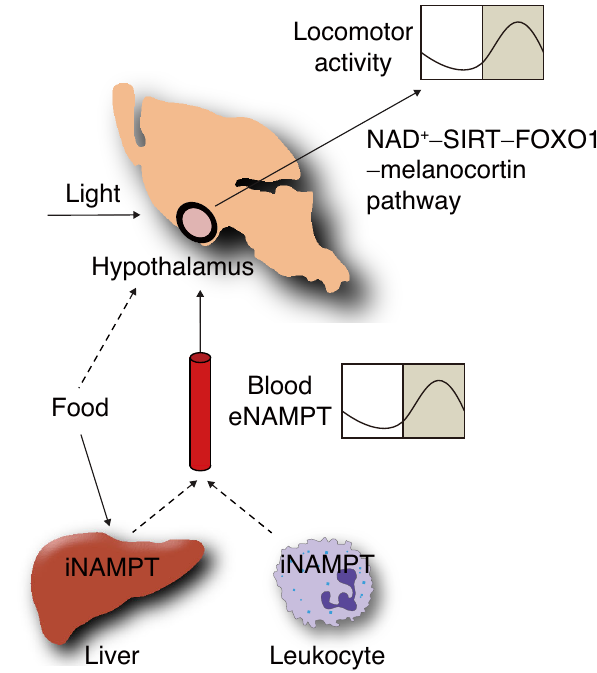
Fig. 8 | Schematic illustration of a potential role for eNAMPT in hypothalamic circadian regulation of locomotor activity. Light and food availability control eNAMPTsecretionfromtheliverorleukocytestosystemiccirculationinacircadian manner.Blood eNAMPTacts uponthe hypothalamus to drive circadian rhythmsin locomotor activity via hypothalamic NAD + – SIRT – FOXO1 – melanocortin